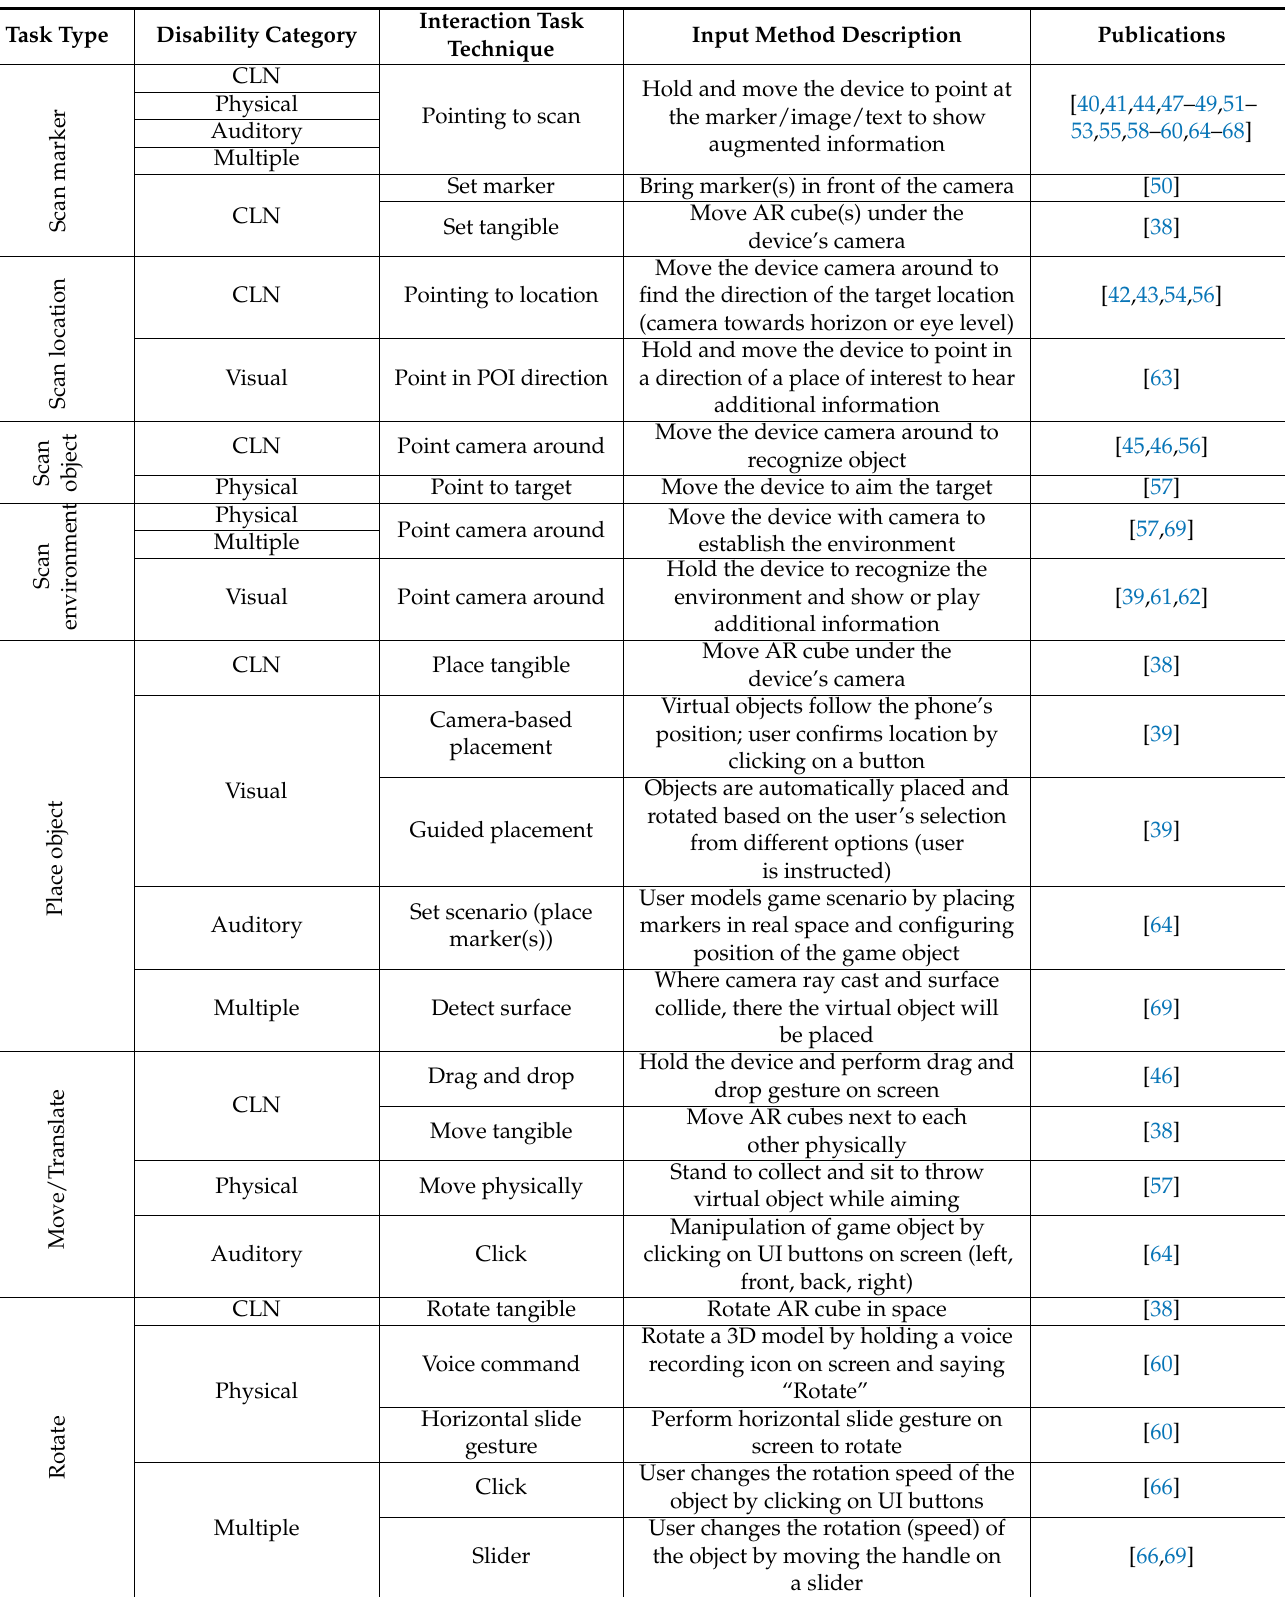
Table 3. Interaction techniques and description of input methods for performing the tasks by task type and disability